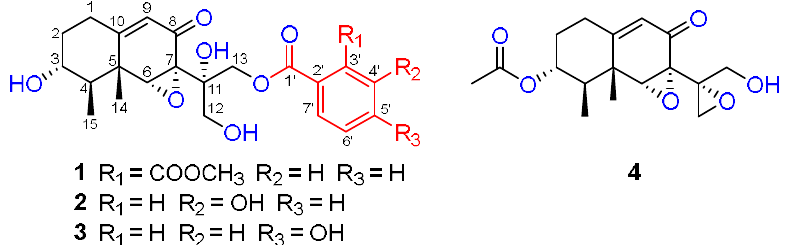
Figure 1. Chemical structures of compounds 1 – 4 . Table 1. 1 H and 13 C NMR Spectroscopic Data for 1 and 2 in Methanol- d 4 ( δ in ppm, J in Hz).